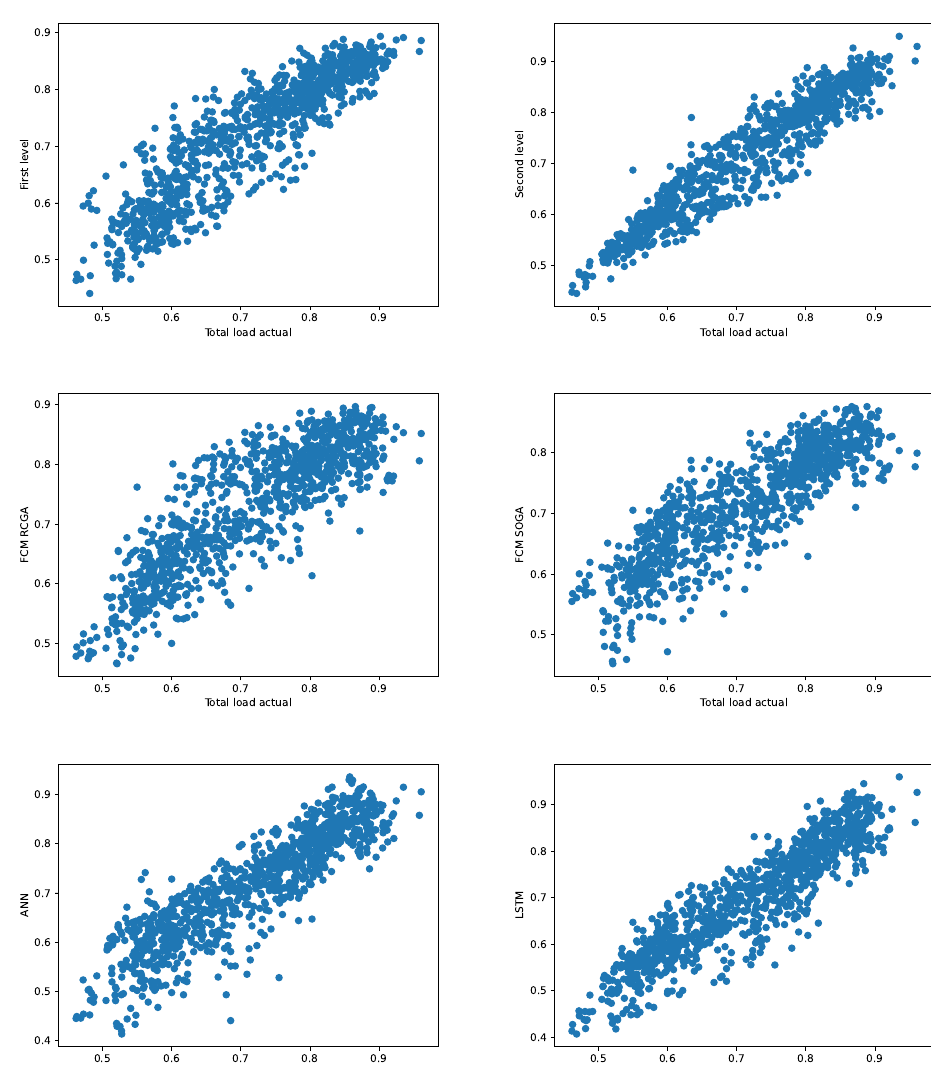
Figure 6. Scatter plots for the best models obtained with the use of the nested structure (first level, second level), FCM approaches (RCGA, SOGA), the LSTM model and the ANN